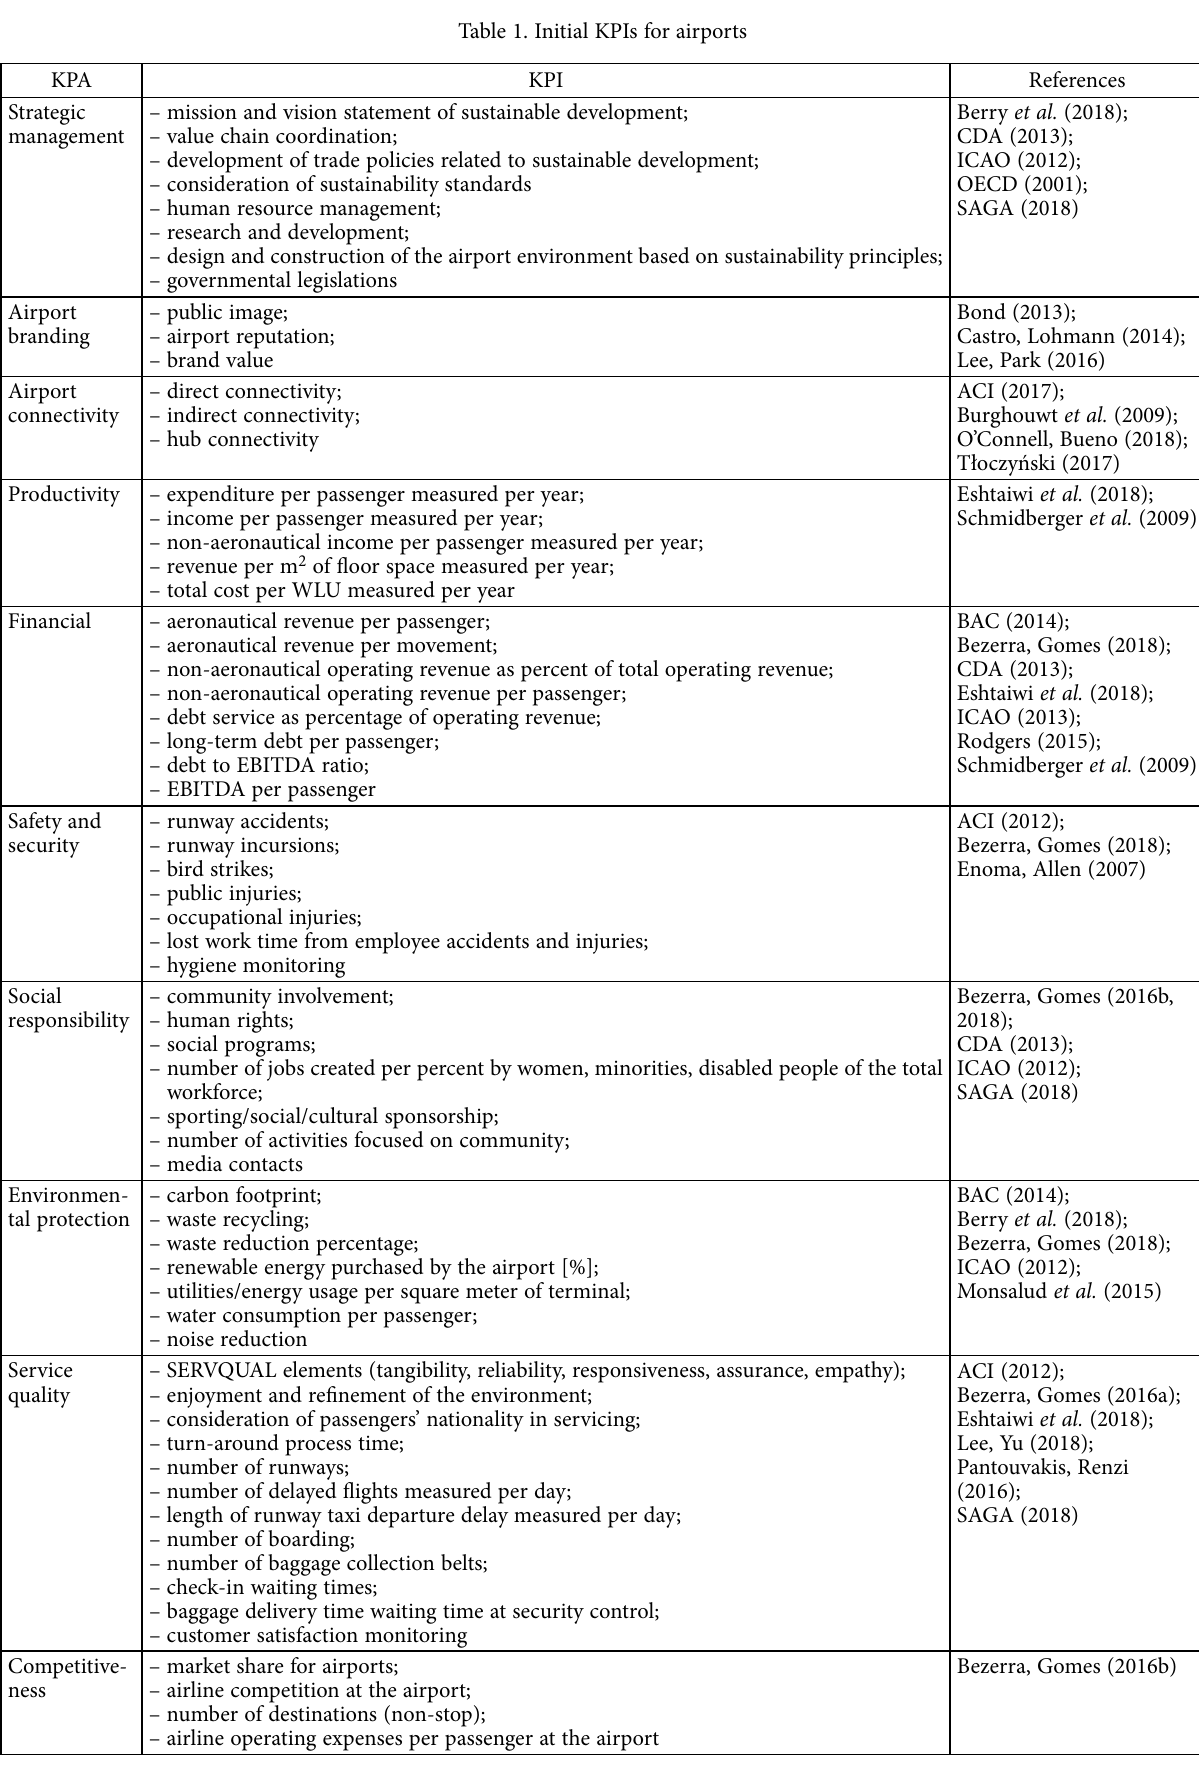
Table 1. Initial KPIs for